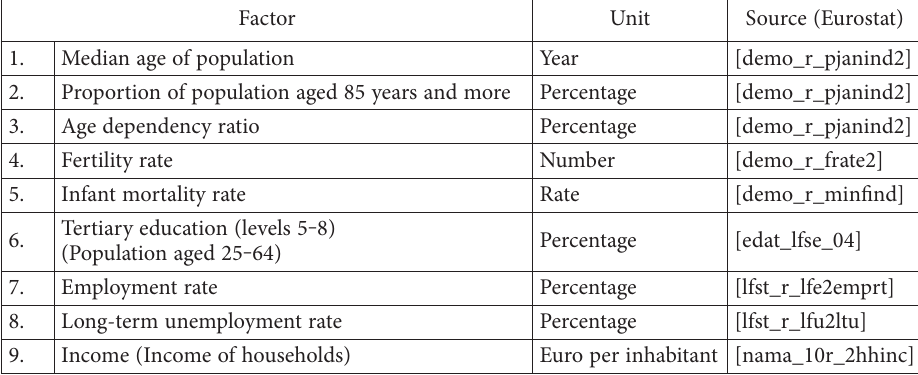
Table 1. Sources of used databases and